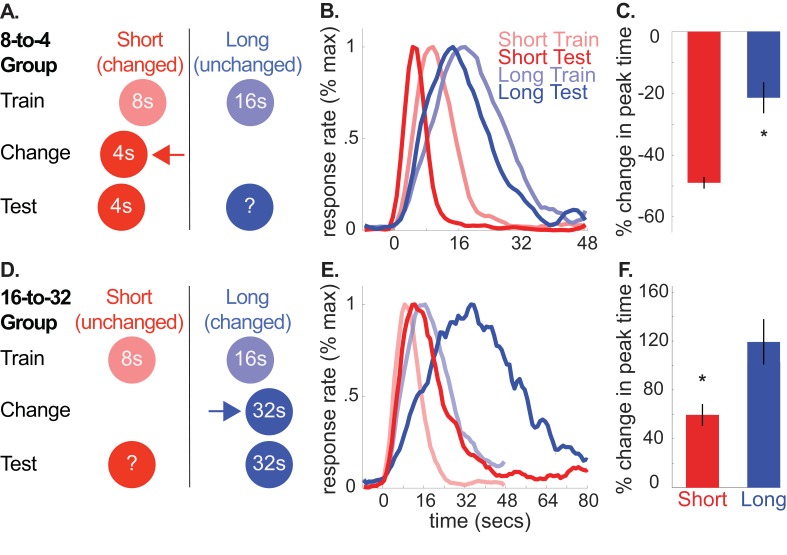
A and D depict the general design used for the 8-to-4 (n = 10) and 16-to-32 (n = 10) groups, respectively.(B) and (E) show average normalized response rate during probe trials during initial training and testing for the 8-to-4 and 16-to-32 groups, respectively. For presentation, each curve was normalized by the maximum value and smoothed over a 6-bin window. (C) and (F) show percent-change in peak time during testing (±SEM), relative to initial training for the 8-to-4 and 16-to-32 groups, respectively. Stars indicate significance (p<0.05).10.7554/eLife.38790.010Figure 1—source data 1.Data used to generate Figure 1.10.7554/eLife.38790.009Figure 1—source data 2.Table showing percent change in peak, start, and stop times (+/- SEM) for the unchanged cue across all experiments.Stars indicate significance under an alpha level of .05. Tildes indicate marginally significant effects (p < .1).